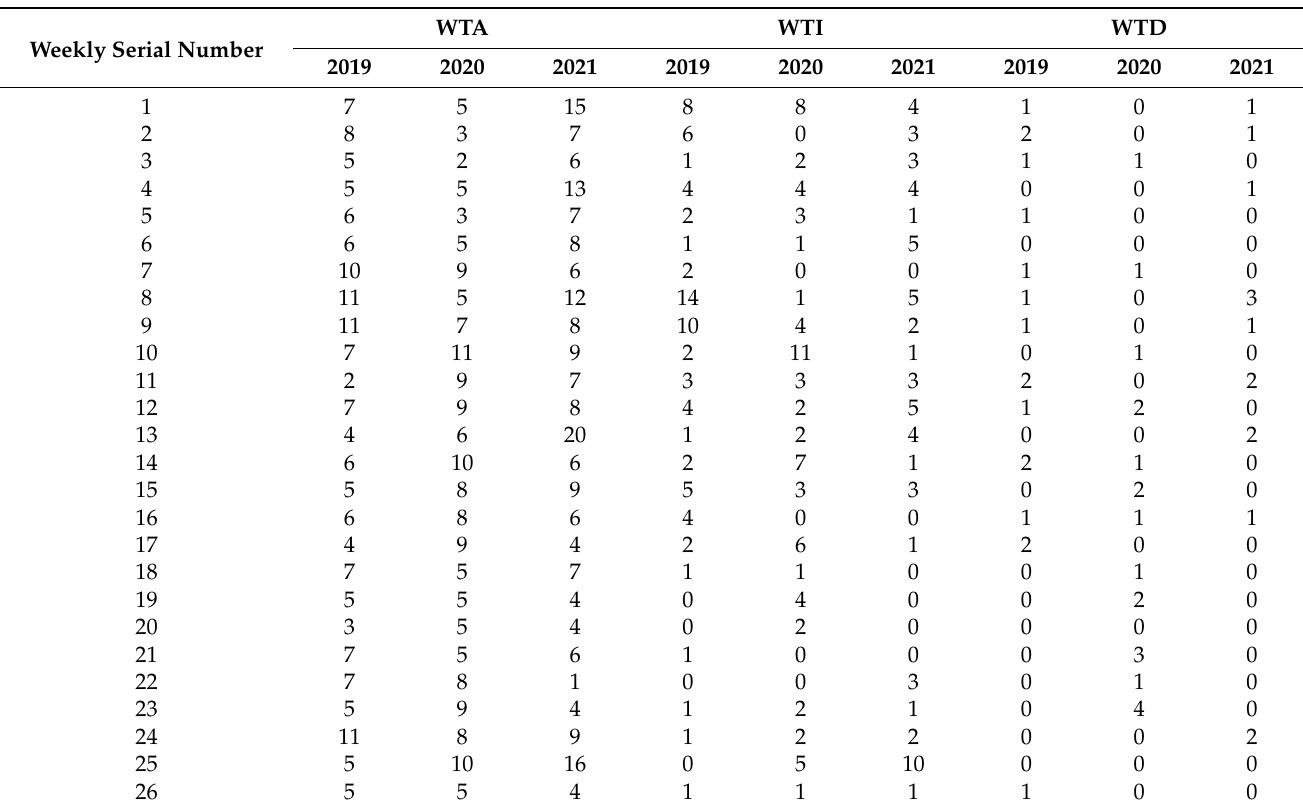
Table 2. Time series analysis dataset of the NPTHN safety level assessment